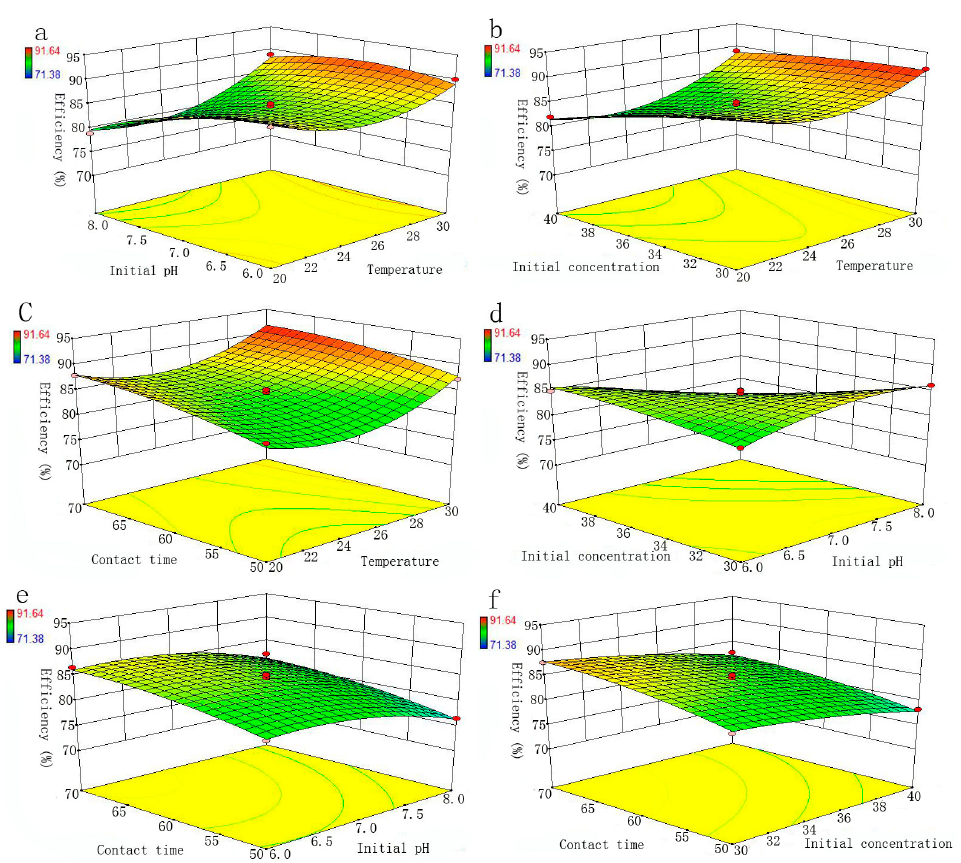
Figure 4. The 3-D surface plots for interactive effect of temperature and initial pH ( a ); initial Se(IV) concentration and temperature ( b ); contact time and temperature ( c ); initial pH and initial Se(IV) concentration ( d ); contact time and initial pH ( e ) and contact time and initial Se(IV) concentration ( f ); on the removal of the Se(IV) (the red dot represents the center point).